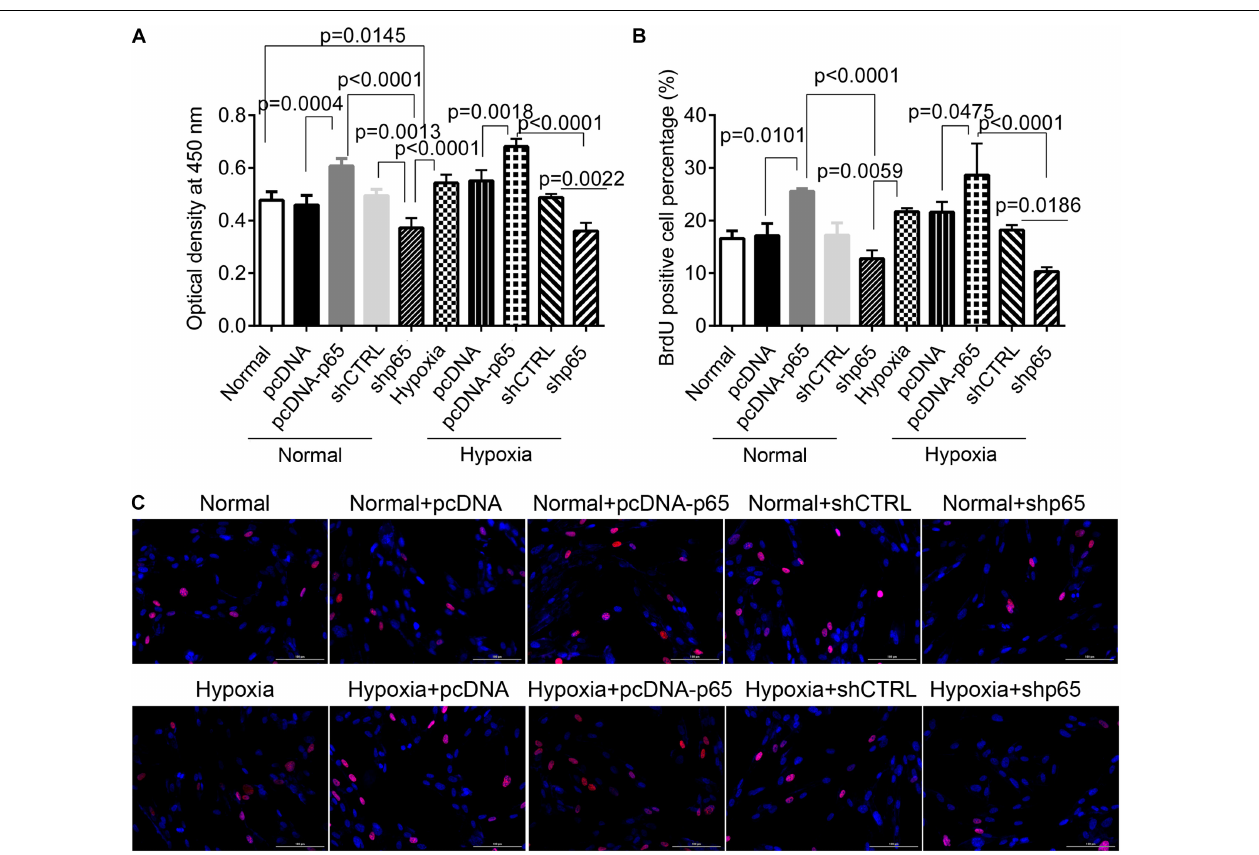
FIGURE 2 | The effect of p65 expression on hPASMC proliferation. (A) The cell viability of hPASMC following pcDNA-p65, shp65, and hypoxia using the CCK-8 assay kit. Each experiment was repeated three times. (B) The percentage of BrdU-positive hPASMCs following different treatments. The differences were analyzed using one-way ANOVA. (C) The representative images of BrdU-positive cells following different treatments. CTRL, control.